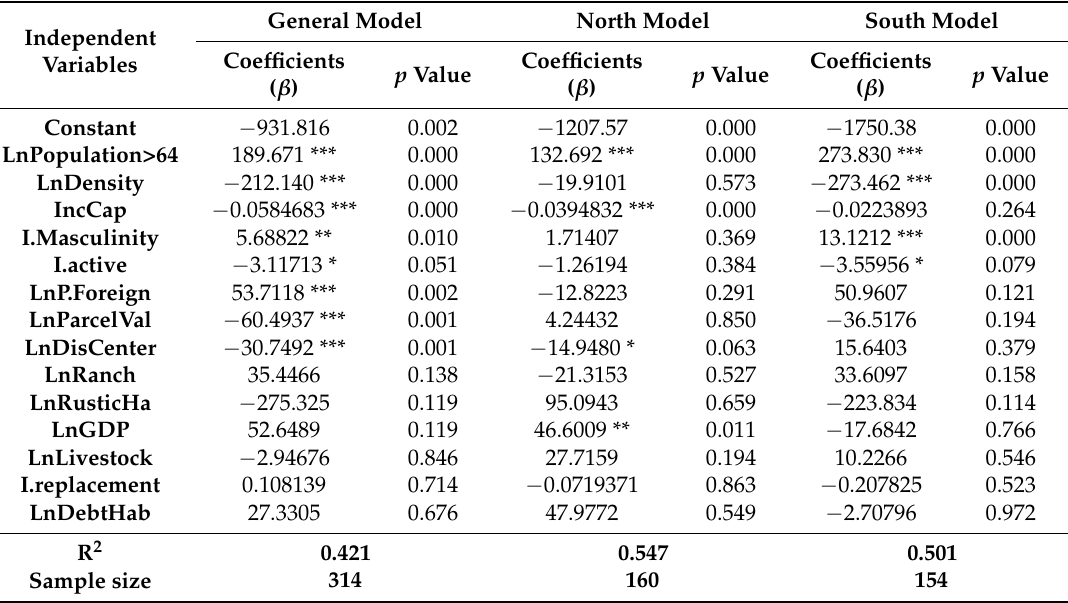
Table 2. Empirical results of the model. Dependent variable: number of